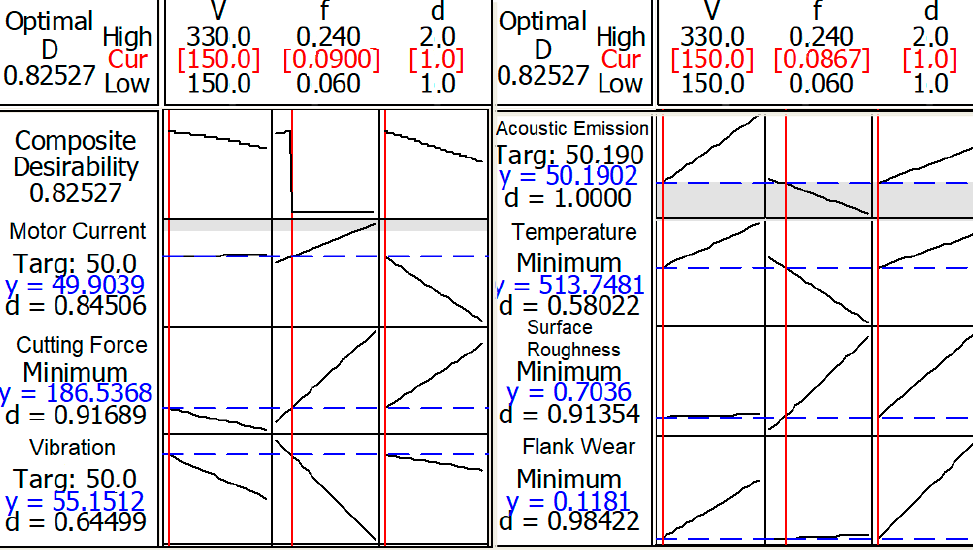
Table 8. Comparison of experimental and predicted results for all variables.